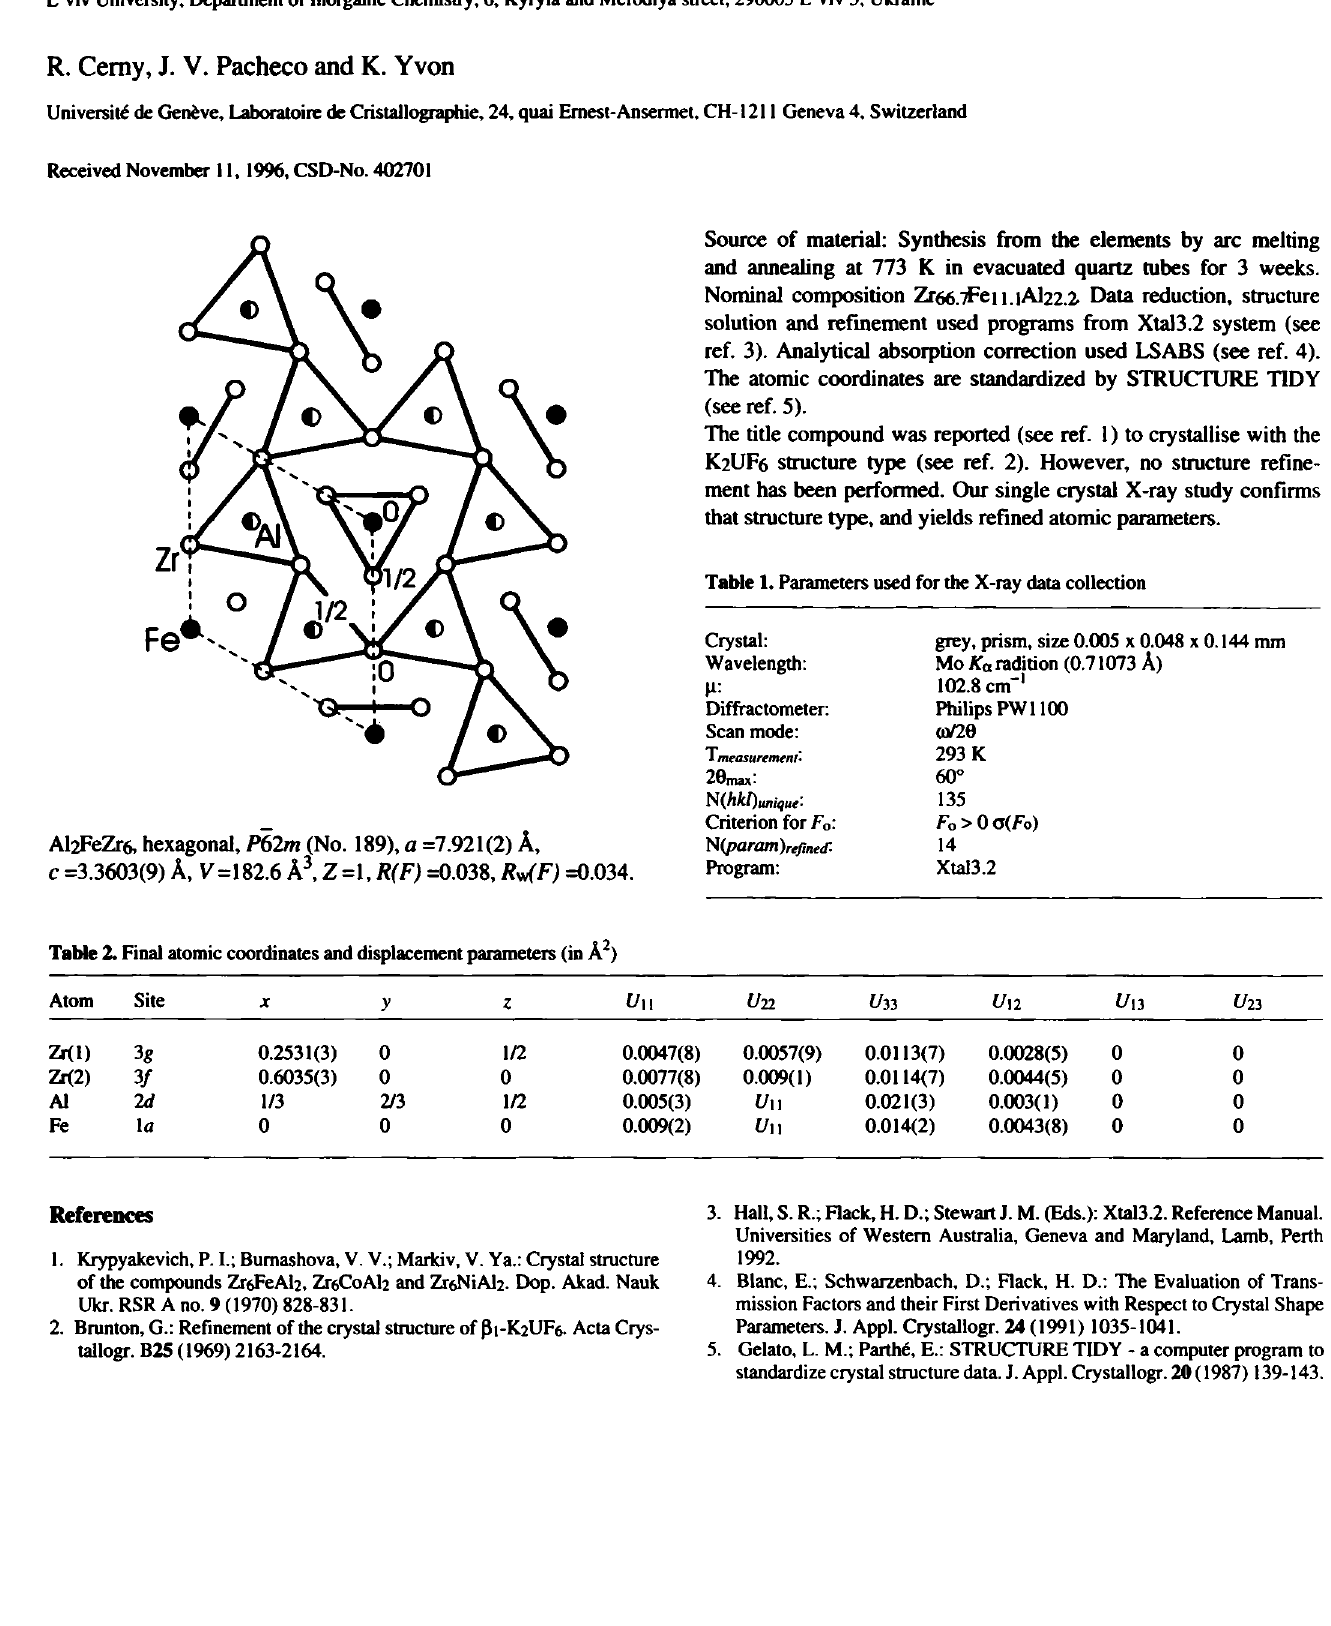
Table 2. Final atomic coordinates and displacement parameters (in Â 2